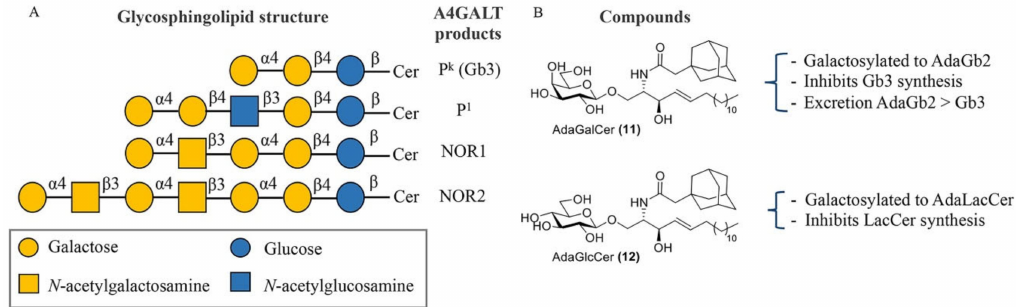
Figure 6. A4GALT glycosphingolipid (GSL) products and Gb3 modulators. ( A ) Structures of glycosphingolipids produced by A4GALT. ( B ) AdaGalCer 11 and AdaGlcCer 12 and their effect on GSL